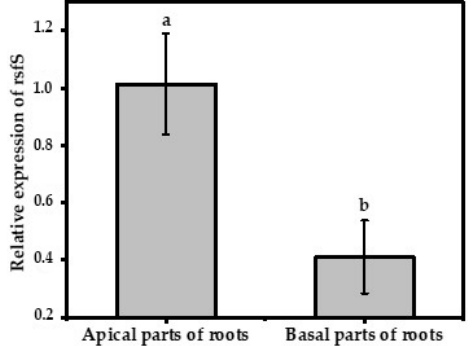
Figure 3. An RT-qPCR-based comparison of the relative rsf S gene expression in P.putida PCL1760 under the colonization of tomato root parts. Data are represented as mean ± SD. The significant difference between bacterial strains was evaluated using one-way ANOVA and post hoc Tukey’s honestly significant difference test at a p -value ≤ 0.01. Significant difference among groups is labeled with different letters (a and b).